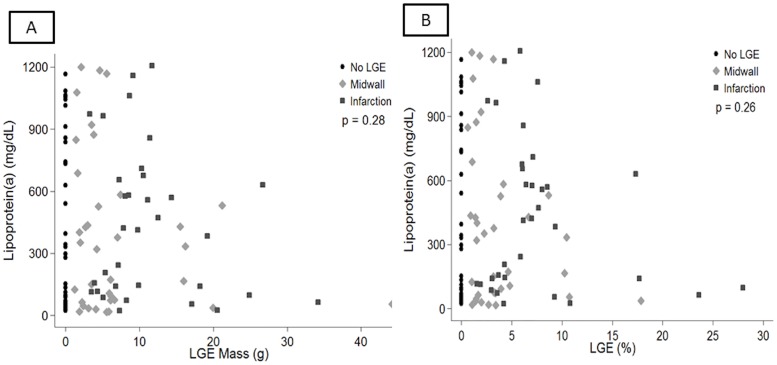
investigating a potential association between quantified enhanced myocardial mass or % mass and Lp(a).As shown in panel A, there was no association between enhanced mass and Lp(a) (p = 0.28). Reviewed separately there was no association between Lp(a) and midwall fibrosis (p = 0.20) or infarction (p = 0.31). Similarly there was no significance for enhanced % mass as shown in panel B.